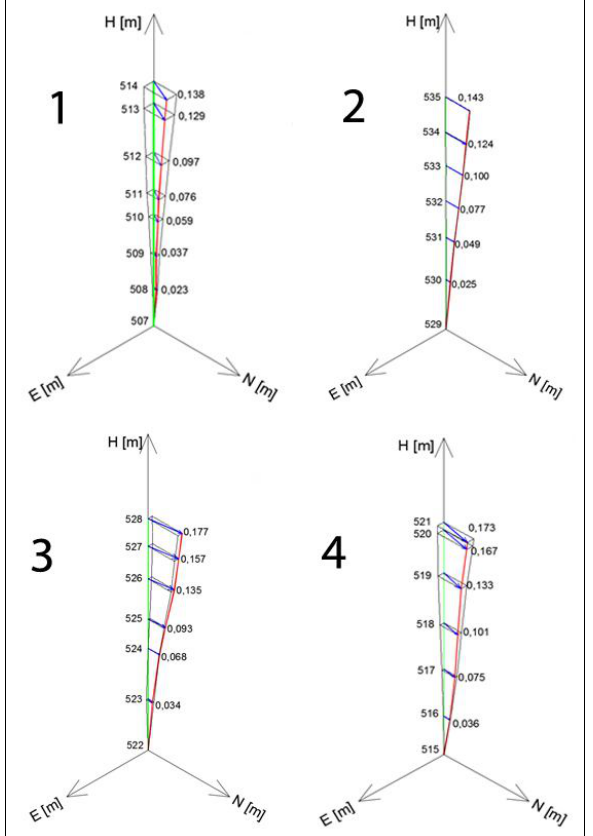
Figure 8. Axonometric representation of the pillars off plumb (amplificated by a factor of